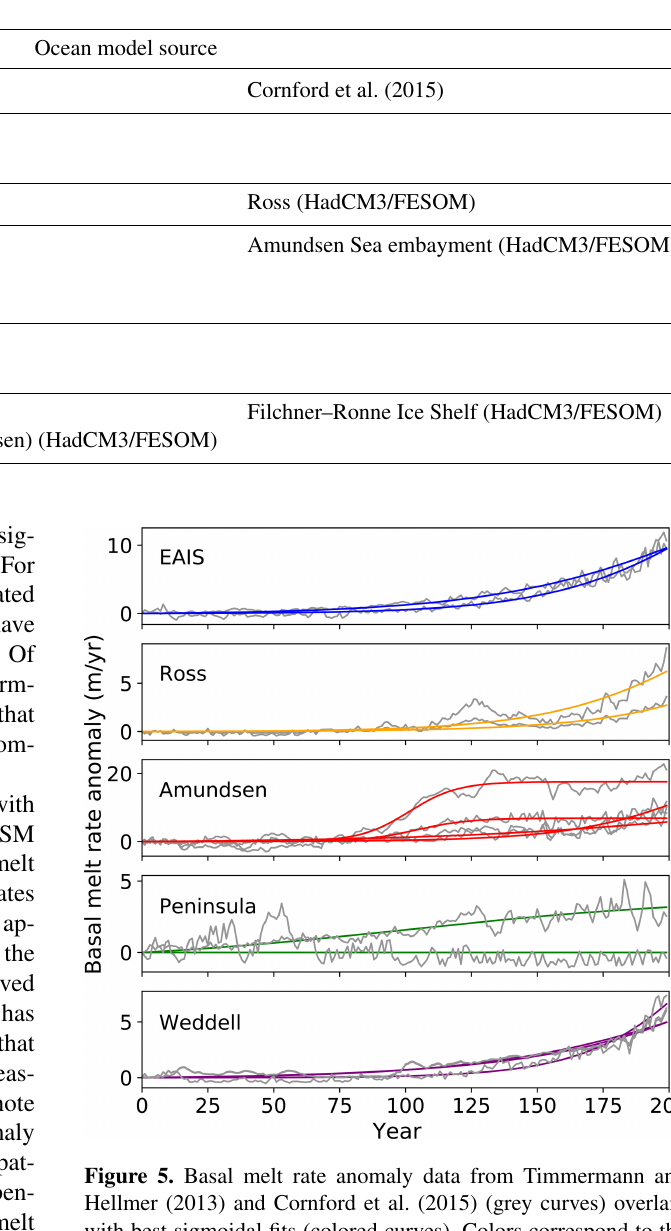
Table 1. Sources of ocean model output used in this study. Parentheses include specifications on the global climate model/regional ocean model. EAIS denotes East Antarctic Ice Sheet.